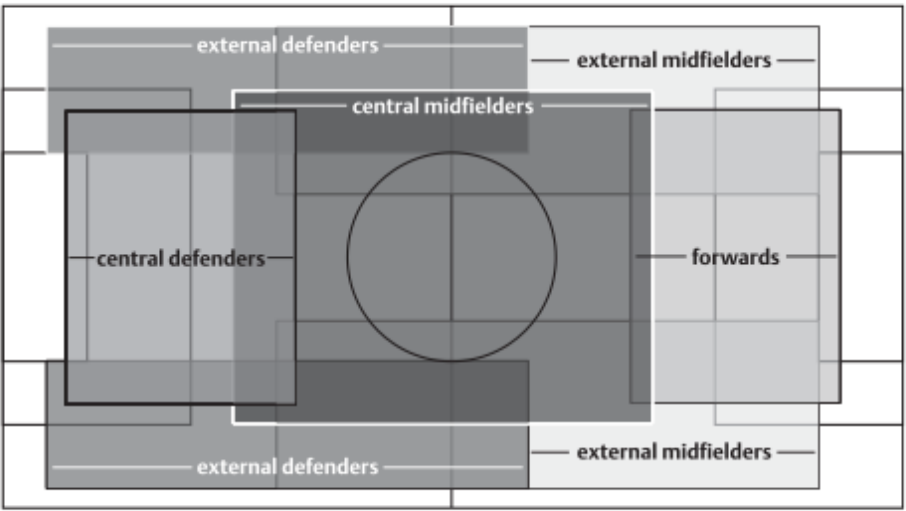
Figure 1. Tactical allocation of game positions based on match analysis 11.